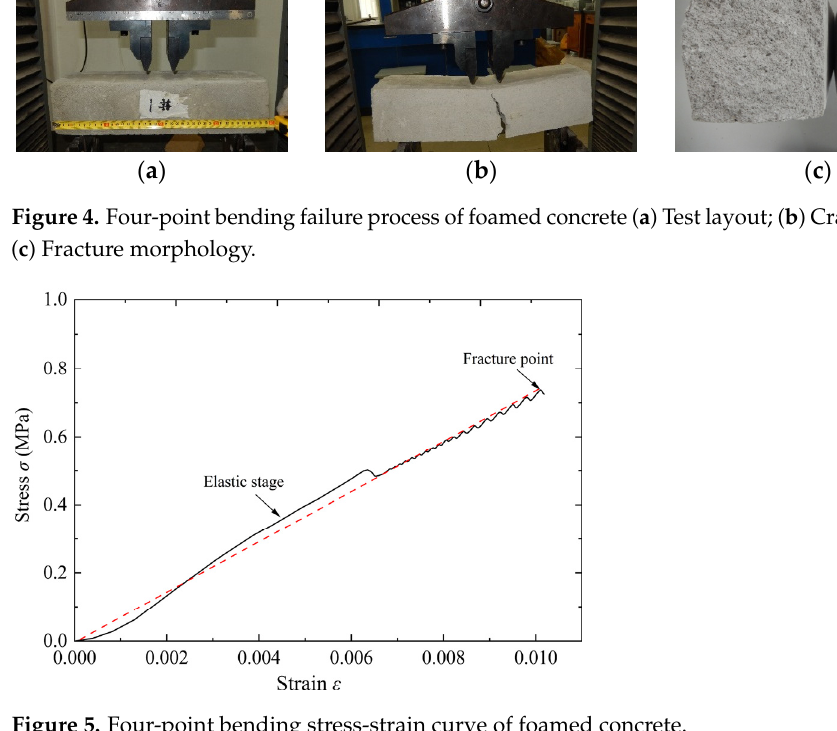
Figure 5. Four-point bending stress-strain curve of foamed concrete.